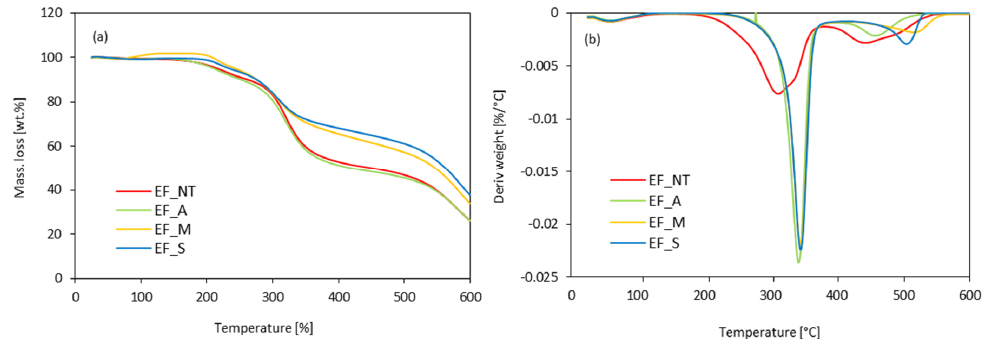
Figure 8. ( a ) thermogravimetric analysis curve (TGA) and ( b ) first derivative of the TGA curve (DTG) obtained for polyurethane foams modified with eucalyptus fibers.